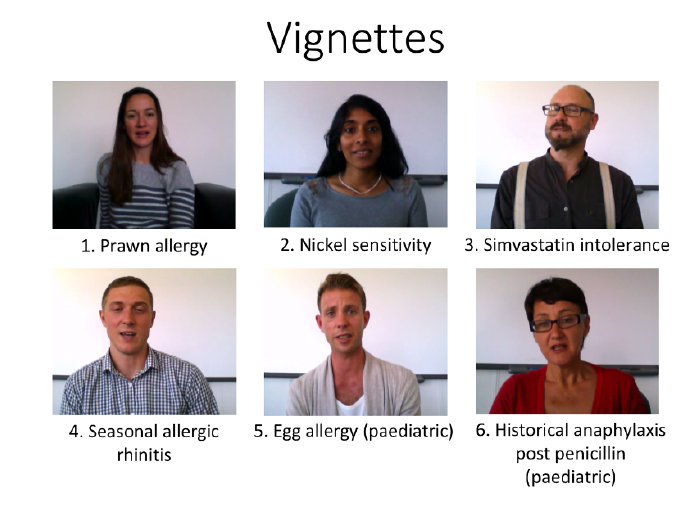
Figure 1: Vignette stills including their clinical presentation